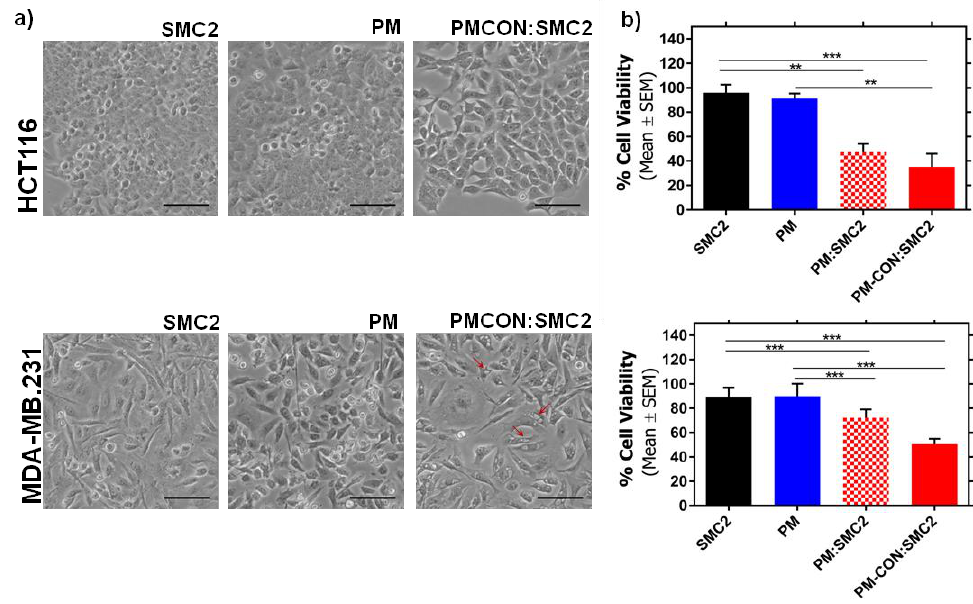
Figure 3. In vitro e ffi cacy of Ab-SMC2 in tumor cell lines. ( a ) Phase contrast images of HCT116 (above panel) and MDA-MB-231 (below) after 48 h incubation with free SMC2 antibody, control PM and PM-CON:SMC2. Red arrows point at vacuoles appeared after PM-CON:SMC2 treatment. Scale bar correspond to 100 µ m; ( b ) cell viability representation of HCT116 (above panel) and MDA-MB-231 (below) after 72 h of incubation with anti SMC2 antibody, control PM, PM:SMC2 and PM-CON:SMC2. The concentrations of the antibody and Pluronic ® 127 were 32.9 µ g / mL and 5 mg / mL, respectively. These concentrations were also maintained in both formulations: PM:SMC2 and PM-CON:SMC2. ** p < 0.01, *** p < 0.001.